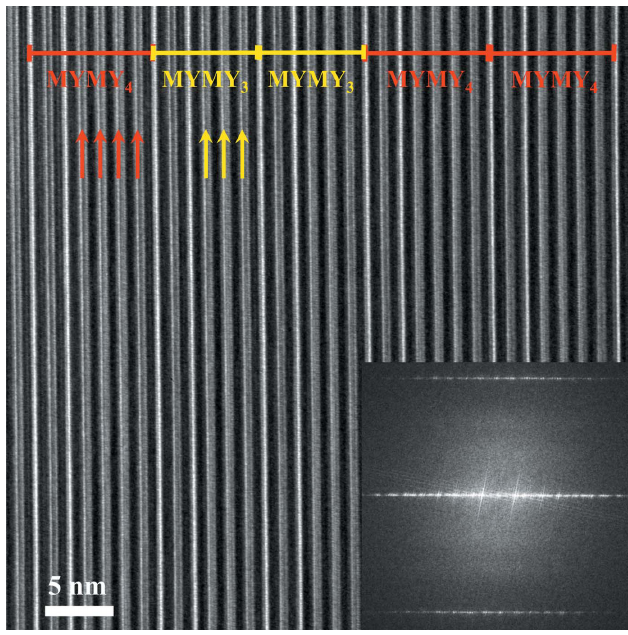
Figure 16 Experimental [120] HREM image collected on an FIB preparation of the (40) 1 hexaferrite single crystal and its corresponding FFT. ‘MYMY 3 ’ defects are observed along the stacking sequence. Here, the FFT is not of sufficient resolution to distinguish the global (95 A˚ ) repeat and the defect (81 A˚